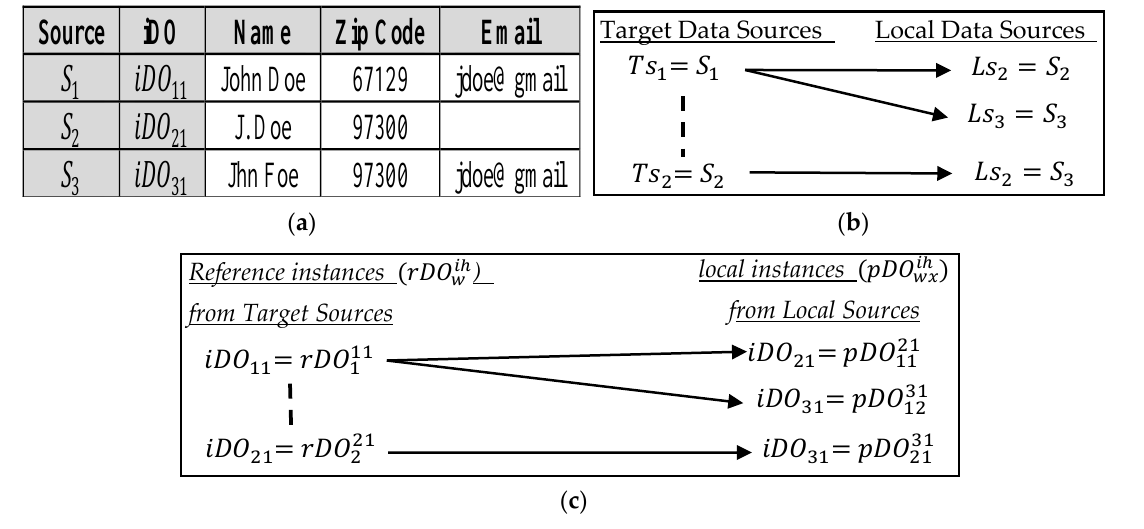
Figure 2. The pair-wise-source-to-target matching and formulation process based on the best effort data integration framework. ( a ) The participated iDO instances as observed from three structured data sources of 𝑆 1 . 𝑡𝑝 1 , 𝑆 2 .𝑡𝑝 1 , & 𝑆 3 .𝑡𝑝 1 . ( b ) The pair-wise-source-to-target matching process for the three structured data sources of 𝑆 1 . 𝑡𝑝 1 , 𝑆 2 . 𝑡𝑝 1 , & 𝑆 3 .𝑡𝑝 1 . ( c ) The pair-wise-source-to-target matching process for the three iDO instances according to their local instance (𝑝𝐷𝑂 𝑤𝑥𝑖ℎ ) or reference instance (𝑟𝐷𝑂 𝑤𝑖ℎ ) formulations.